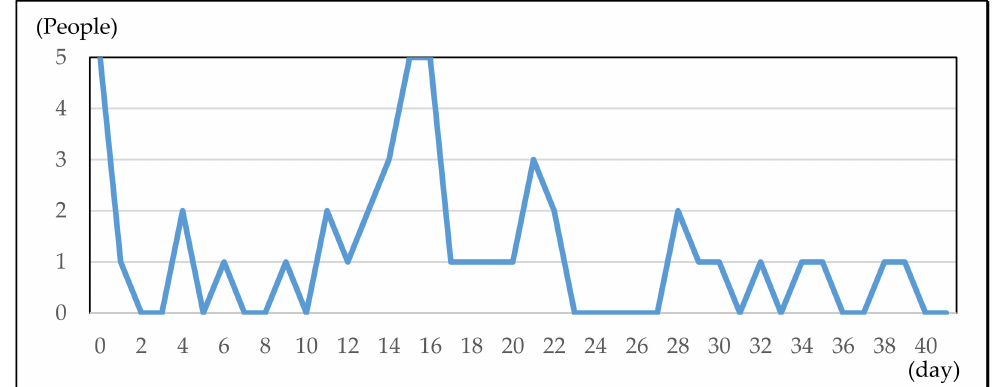
Figure 14. Daily transition of the number of active users during operation of the